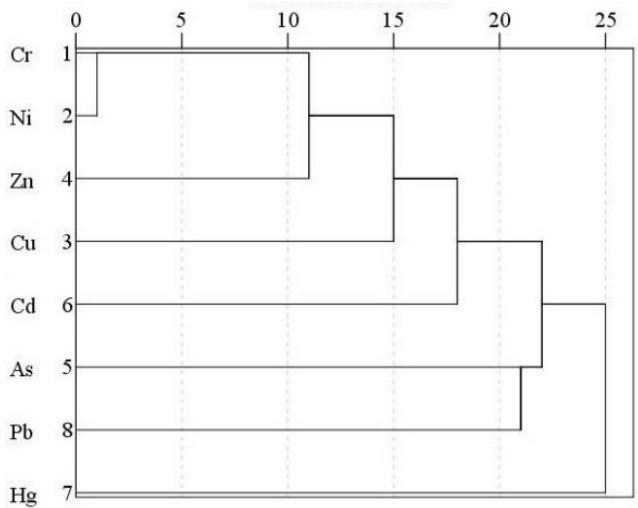
Figure 4. Dendrogram of HCA.